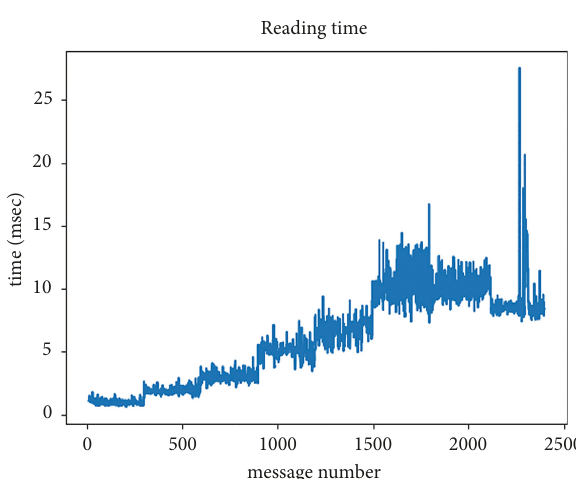
Figure 15: PahoMQTT’s data processing